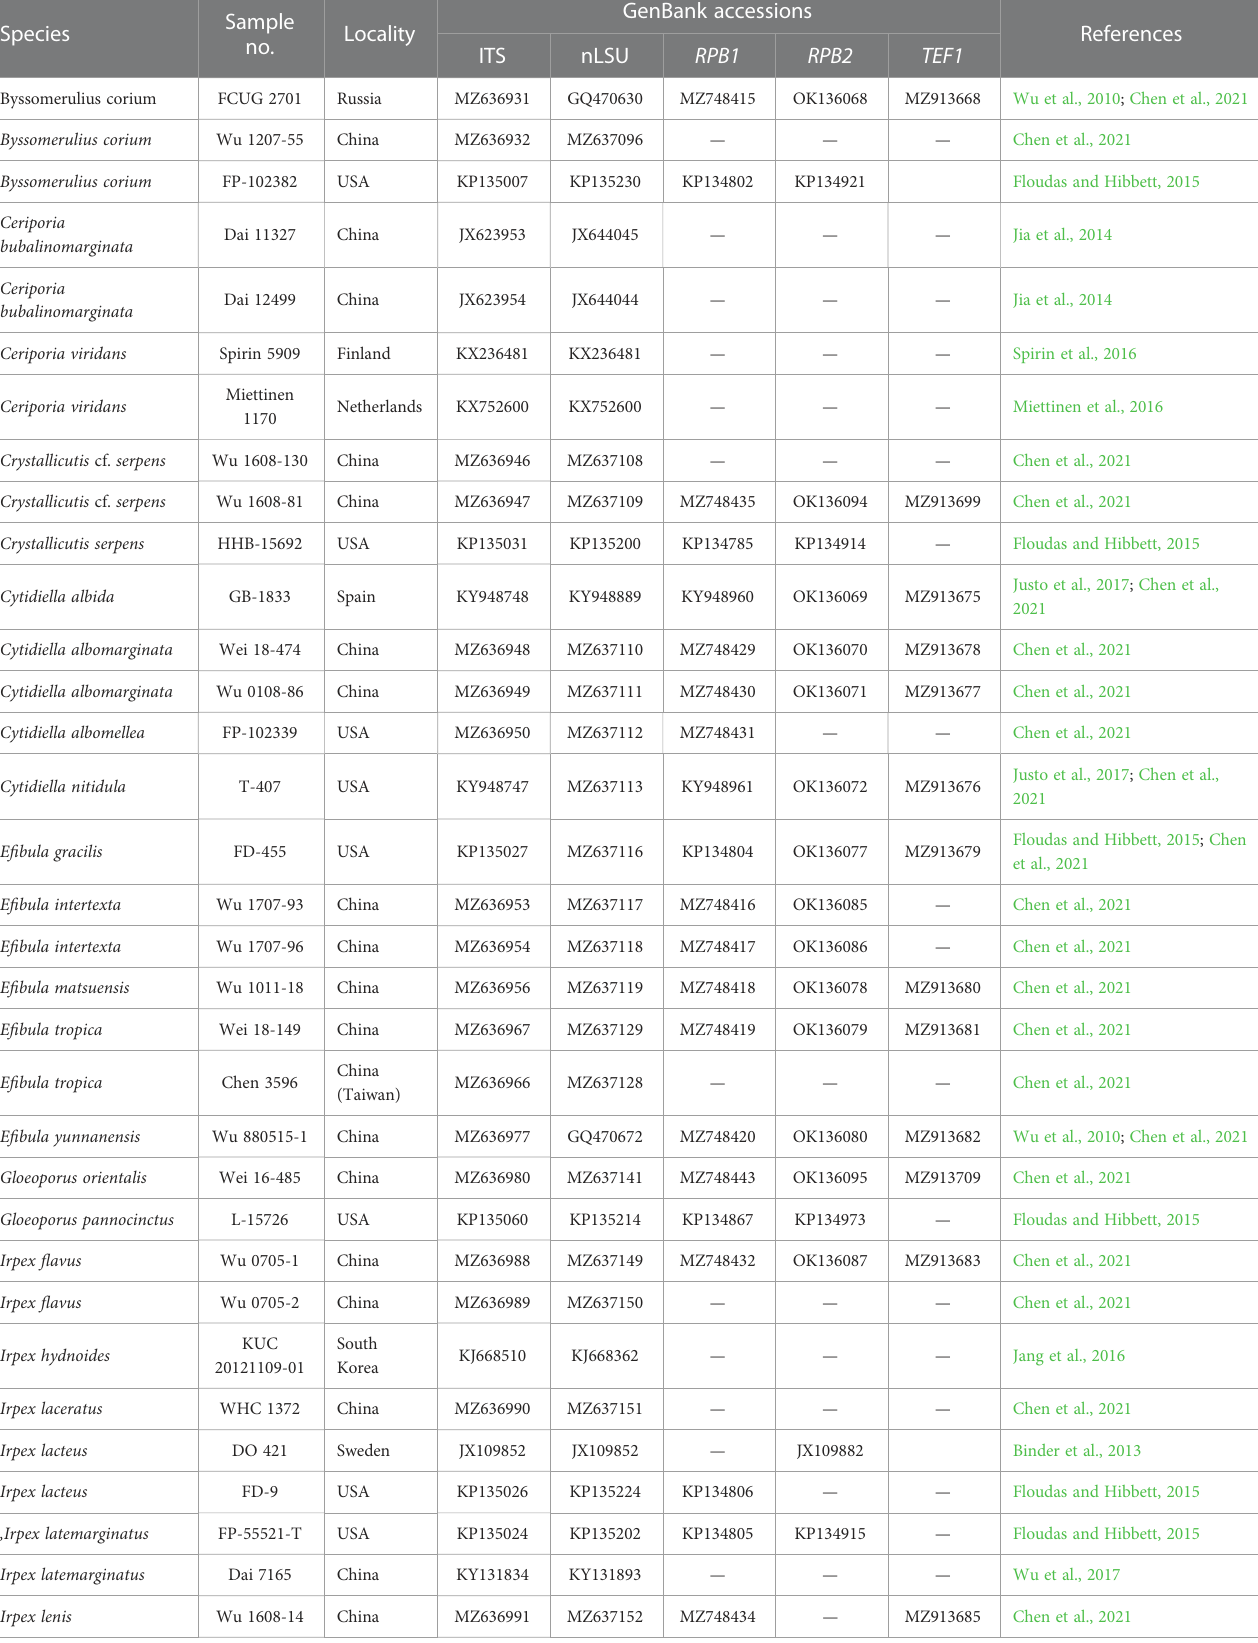
TABLE 1 A list of species, specimens, and GenBank accession number of sequences used for phylogenetic analyses in this study.